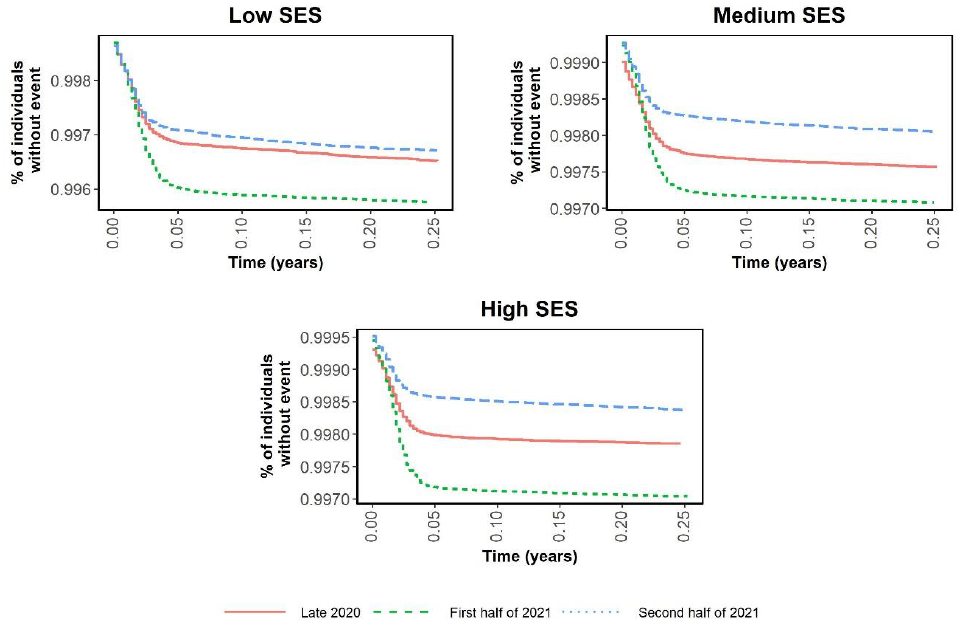
Figure 2. Kaplan–Meier curves of time to hospitalization according to socioeconomic level and Figure 2. Kaplan – Meier curves of time to hospitalization according to socioeconomic level and pe- riod.